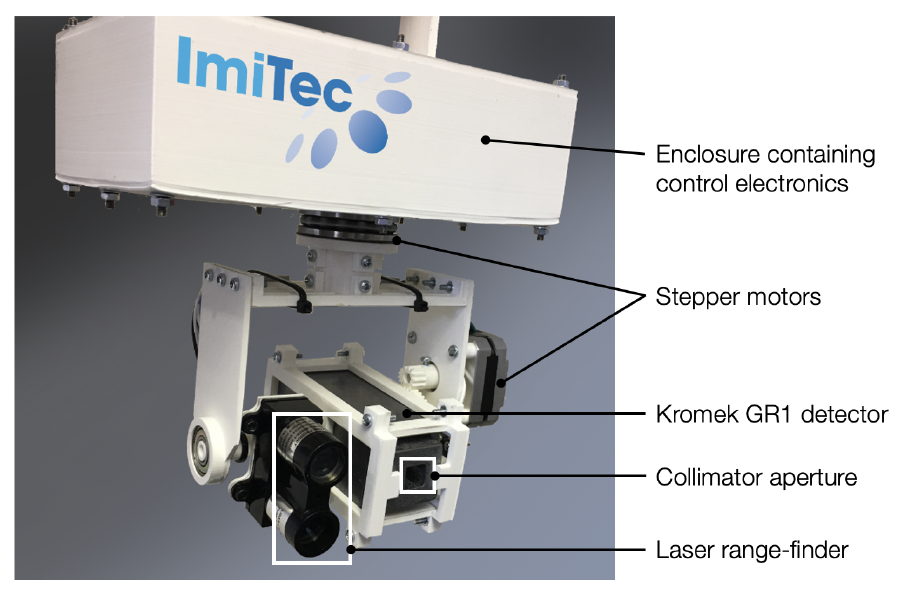
Figure 1. CC-RIAS prototype with components identified To move the two coincident detectors, both are mounted on a custom cradle to allow for raster-scanning of a specified, predefined region. Through the use of stepper motors combined with micro-switches, the dual detector setup can pan through a full 360 ◦ of rotation and tilt through − 40 ◦ to 90 ◦ (the horizontal plane being at 0 ◦ ). This version of the CC-RIAS platform utilises stepper-motors with a minimum per-step angle of 0.9 ◦ . This is sufficient, because as modeled below, this corresponds to a focal length of 0.95 m between aperture and detector surface. Control of the stepper motors motion and speed (dwell-time per point) was provided by a Raspberry Pi (Model B) contained within the sealed plastic enclosure, which additionally served to record this positional data alongside measurement values derived from both the gamma-ray spectrometer and the single-point laser range-finder. The resulting PCD is stored on-board of the device or can be retrieved through a wireless connection in real time. The block diagram is illustrated in Figure